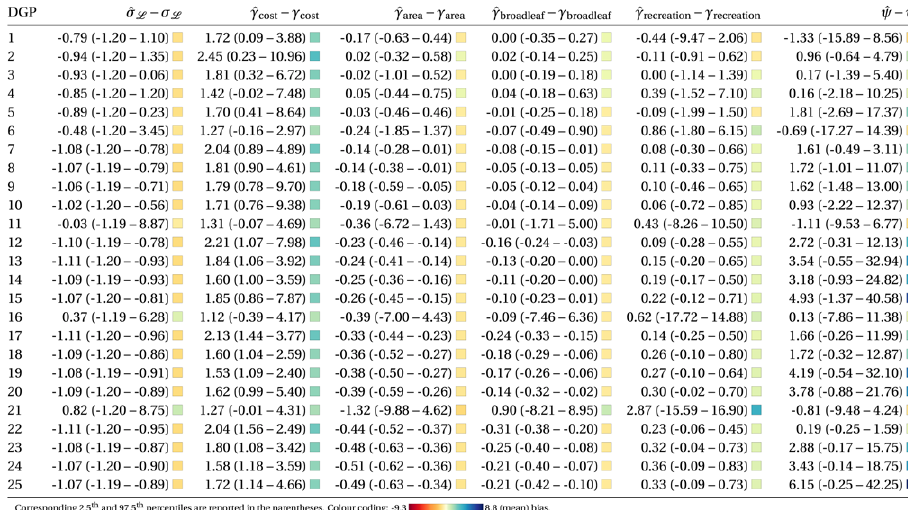
Table 3. Bias for parameters connected with the latent variable in the LVMXL